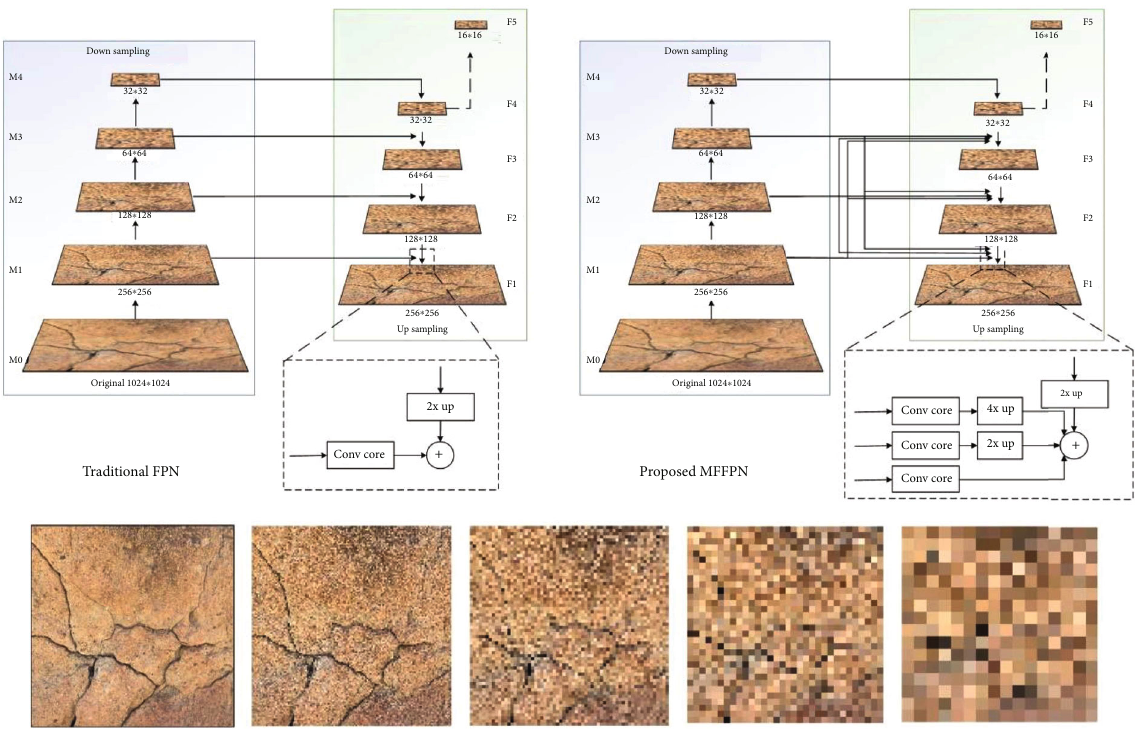
Figure 7: Comparison between traditional FPN and the proposed